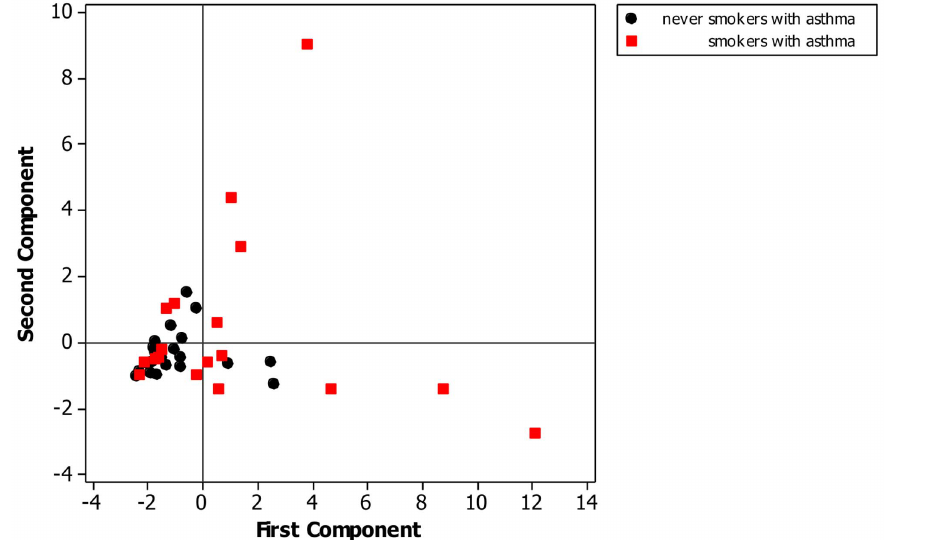
Figure 1. Principal component analysis plot of pre dexamethasone sputum supernatant cytokines (IL1 b , 1RA, 2R, 6, 7, 13, 17, IFN a , GM-CSF, CCL2, 3, 4 & 5, CXCL8, 9 & 10). Principal component 1 represents 52% of variance in data, Principal component 2 21%. Based on examination of the component loadings (Table 3) we interpret principal component 1 as being principally driven by the sputum supernatant cytokines IL1 b , 2R, 7, 12, 13, 17 & GM-CSF principal component 2 to be driven by sputum supernatant IL-6 and the chemokines CXCL9 & 10 & CCL